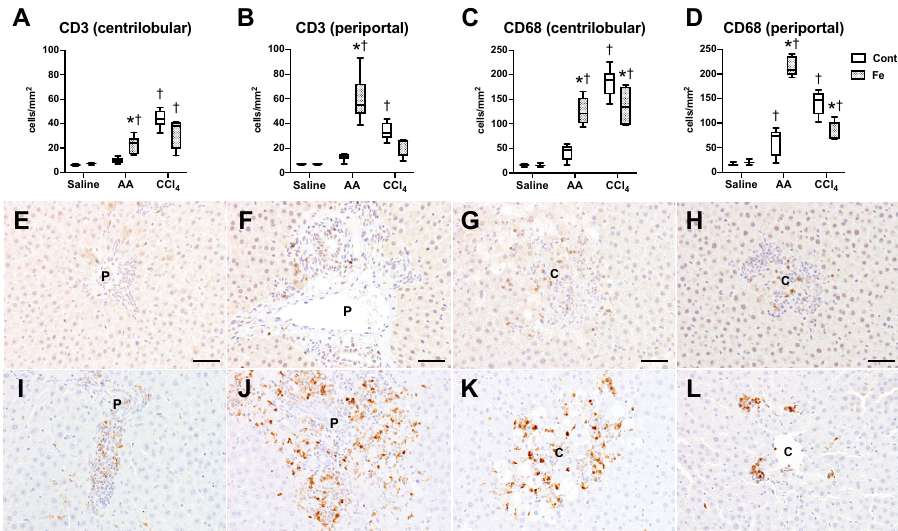
Figure 4. The number of CD3-positive T cells ( A , B ) and CD68-positive macrophages/Kupffer cells ( C , D ) in the centrilobular ( A , C ) and periportal / portal ( B , D ) regions. * p < 0.05 vs. control diet group with same chemical administration (diet factor), † p < 0.05 vs. saline group with same diet feeding (chemical factor), by Sidak’s multiple comparison. Representative images of immunohistochemistry for CD3 ( E – H ) and CD68 ( I – L ) in the liver of Cont-AA ( E , I ), Fe-AA ( F , J ), Cont-CCl 4 ( G , K ), and Fe-CCl 4 ( H , L ) groups. P, portal area; C, centrilobular area. Bar = 50 µm. Nutrients 2019 , 11 , x FOR PEER REVIEW We then analyzed hepatic expression of cytokine genes in terms of Th1/Th2 (T cells) and M1/M2 (macrophages) phenotypes, in order to characterize inflammatory response in our AA and CCl 4 models (Figure 5). In the AA model, expression of Th1- or M1-related cytokines (TNF α , IL6, CCL2 and CXCL1) and Th2- or M2-related cytokines (IL4 and TGF β 1) increased significantly in Fe-AA group compared with that of Fe-saline group; the expression of TNF α , IL6, CCL2 and IL4 was higher in Fe-AA than in Cont-AA group. In the CCl 4 model, expression of Th1- or M1-cytokines (TNF α , IFN γ , IL6, CCL2 and CXCL1) and Th2- or M2-cytokines (IL10 and IL4) increased in Cont-CCl 4 group compared with that in Cont-saline group; the upregulation of TNF α , CXCL1 and IL10 was suppressed by iron overload (Fe-CCl 4 ). Of the nine cytokine genes examined in this study, expression pattern of TNF α , IL6, CCL2 and IL4 was related with that of serum transaminases and inflammatory cells.